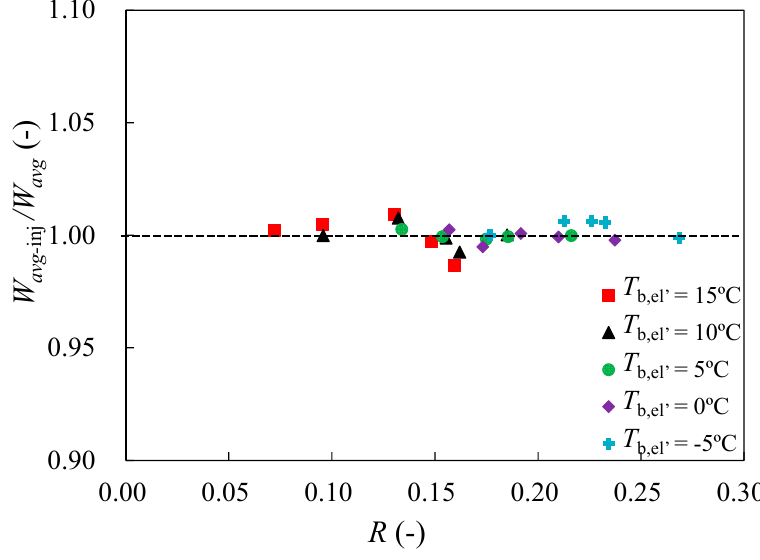
Figure 14. The normalized power consumption W avg-inj / W avg with the injection ratio R of the vapor injection heat pump cycle.